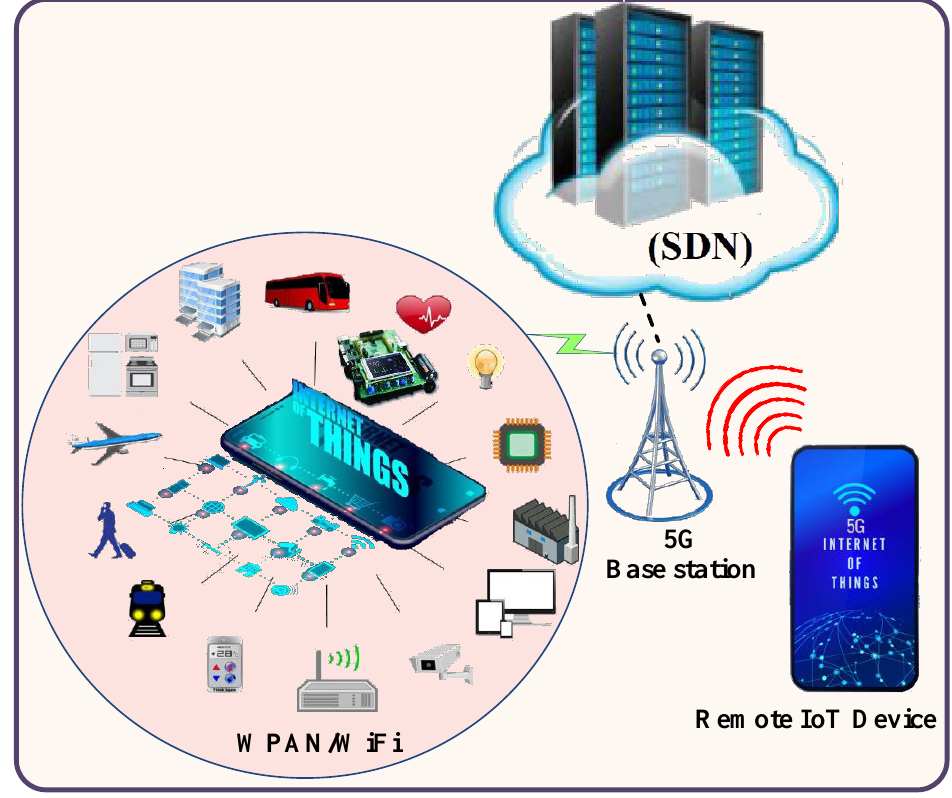
Figure 1. Emergence of the Internet of Things (IoT) architecture.